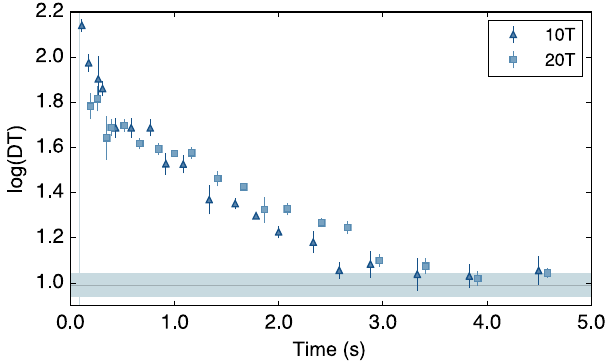
FIG. 11. Time evolution of DT at θ ¼ 0 ° for rotating the field after a waiting time of 10 T (triangle) and 20 T